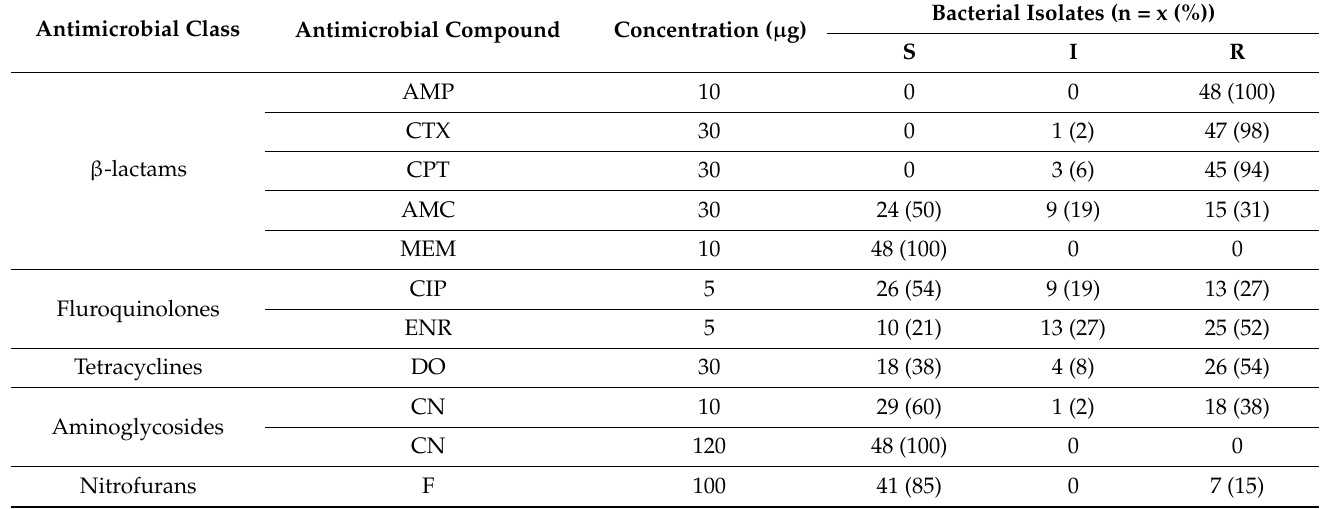
Table 2. Antimicrobial susceptibility profile of the isolates under study, regarding eleven antimicro- bials belonging to five different